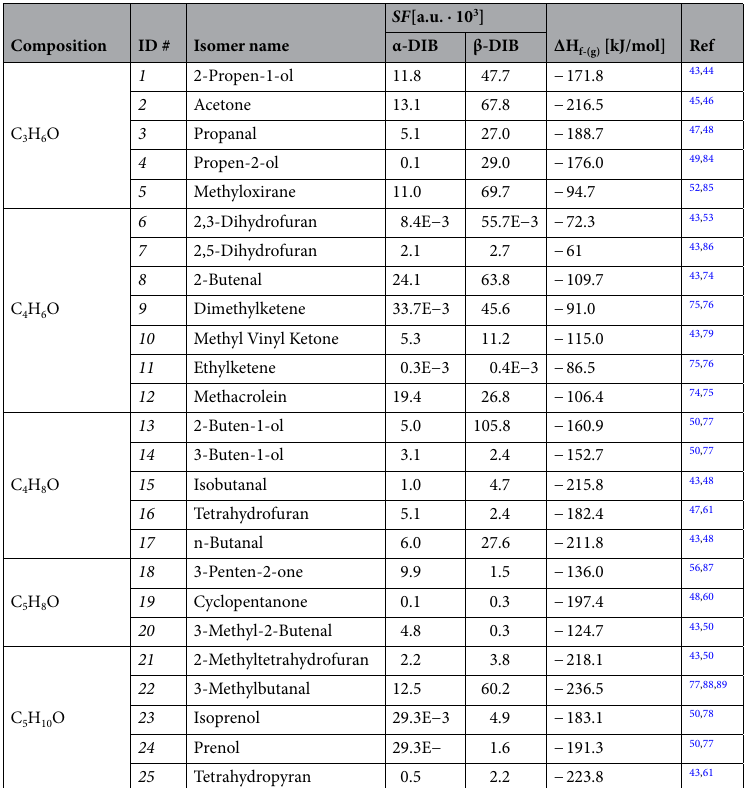
Table 2. Oxygenated intermediates identified in DIB reactions with respective scaling factors and gas-phase heat of formation